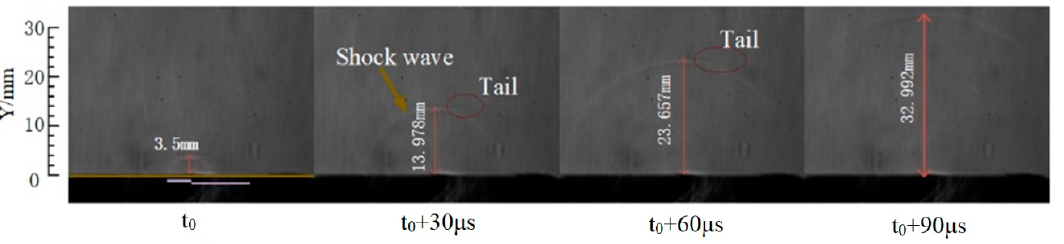
Figure 14. Visualization of the propagating induced wave.